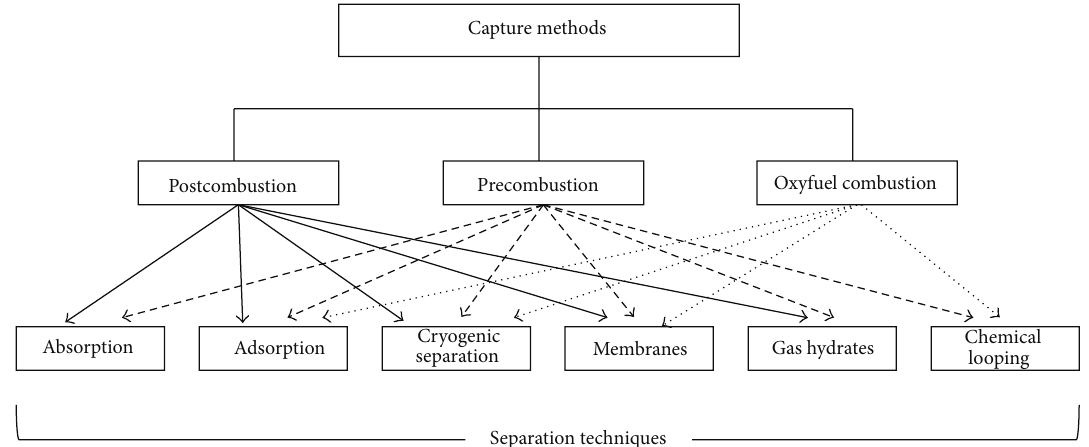
Figure 1: Possible techniques that can be used in conjunction with the processes of postcombustion, precombustion, and oxyfuel